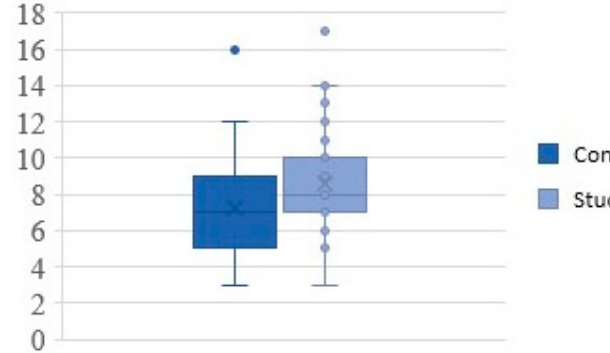
Figure 2. Duration of hospitalization (in days).